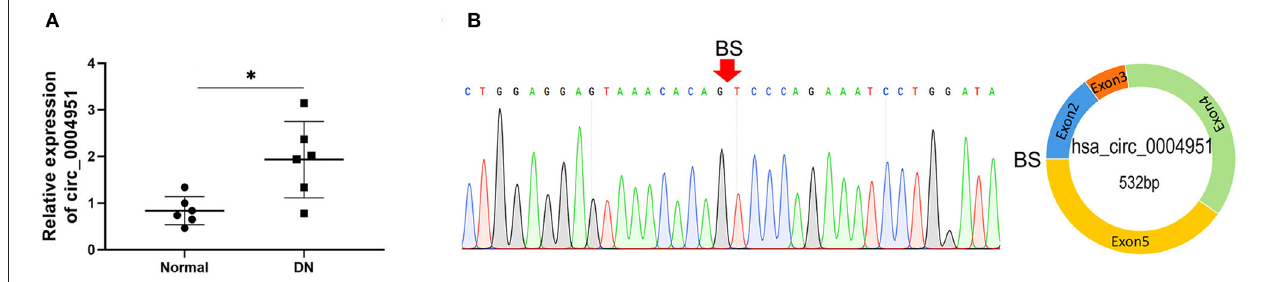
FIGURE 2 | Upregulation of circ_0004951 in renal tissue from DKD patients. qRT-PCR results showing levels of circ_0004951 expression in renal tissues from DKD patients ( n = 6) and normal renal tissue ( n = 6) (A) . Presence of BS sites in kidney tissue RNA from DKD patients following amplification and sequencing with divergent primers (B) . DKD, diabetic kidney disease; qRT-PCR, quantitative real-time polymerase chain reaction. * p < 0.05 vs. normal